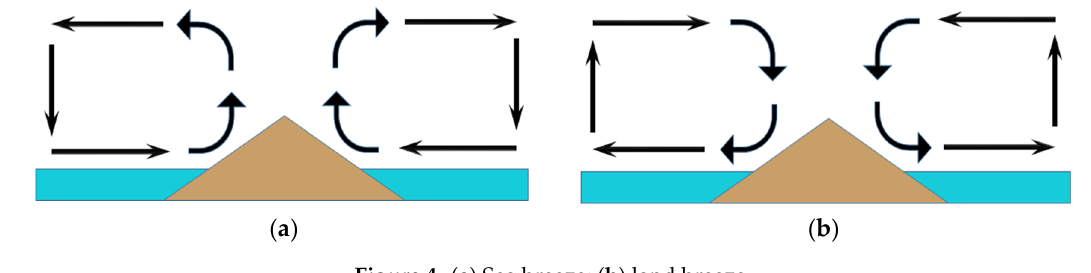
Figure 4. ( a ) Sea breeze; ( b ) land